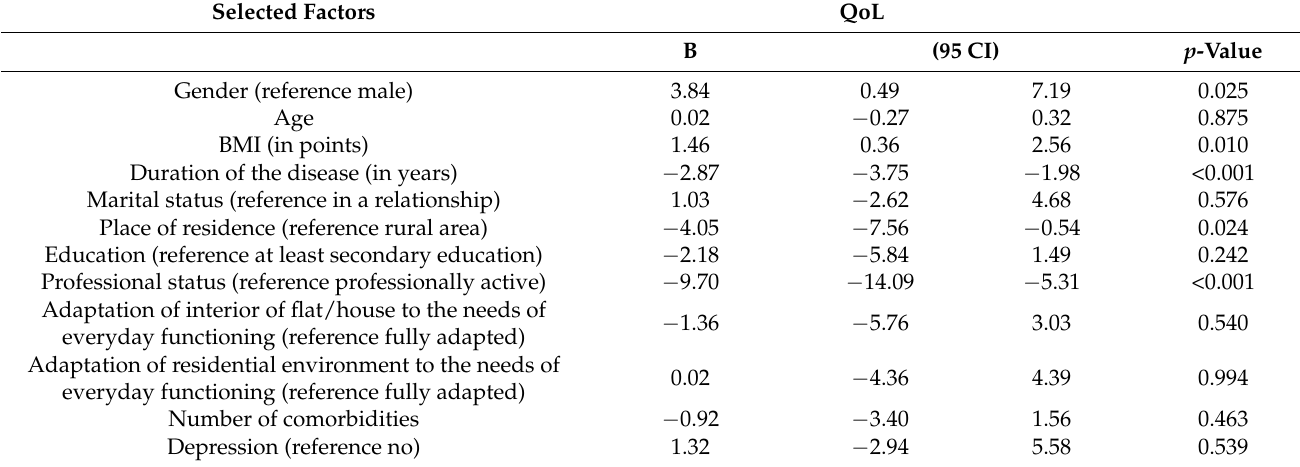
Table 6. Impact of factors related to the level of